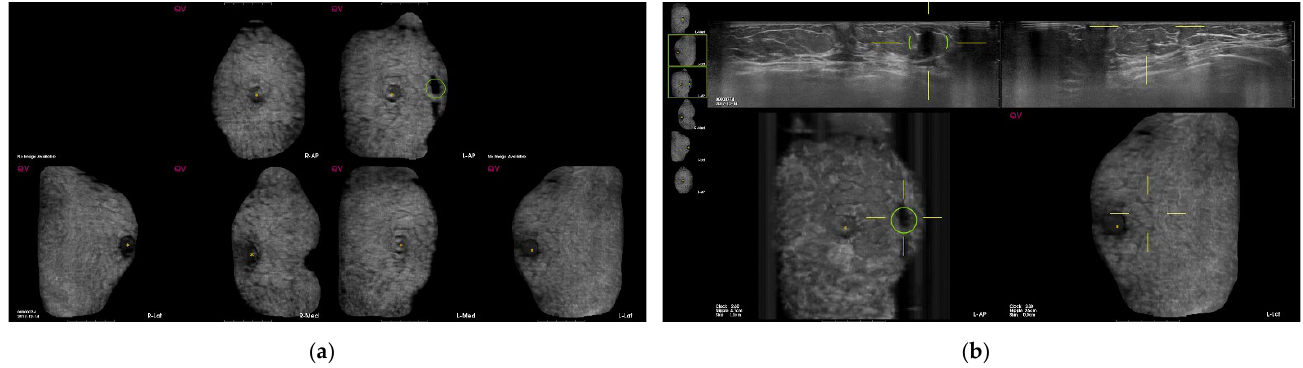
Figure 4. Screening automated breast ultrasound (ABUS) of a 48-year-old woman reveals false-positive marks due to skin lesions. ( a ) CAD-based minimum intensity projection (MinIP) of an ABUS scan in the AP, medial, and lateral sides of both breasts. There is a dark spot with a green circle. ( b ) The lesion showing a dark spot with a green circle on the AP side of the left breast confirms the pseudolesion due to a skin lesion in the transverse scan.